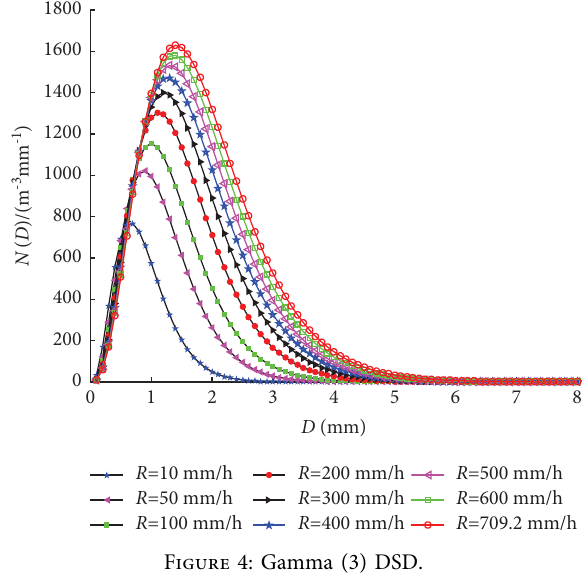
Figure 6: Spatial isometric